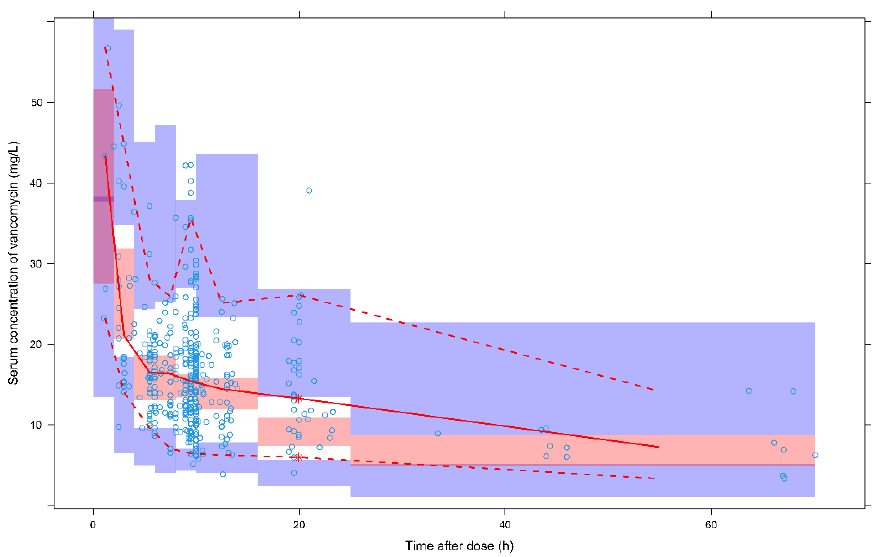
Figure 2. Prediction corrected-visual predictive check (pc-VPC) plot of the final model. Blue circles: observed vancomycin concentrations. Red solid and dashed lines: the 50th, 5th, and 95th percentiles of the observed concentrations. 3 shaded areas: the 90% CIs of the 5th, 50th, and 95th percentiles of the simulated concentrations.